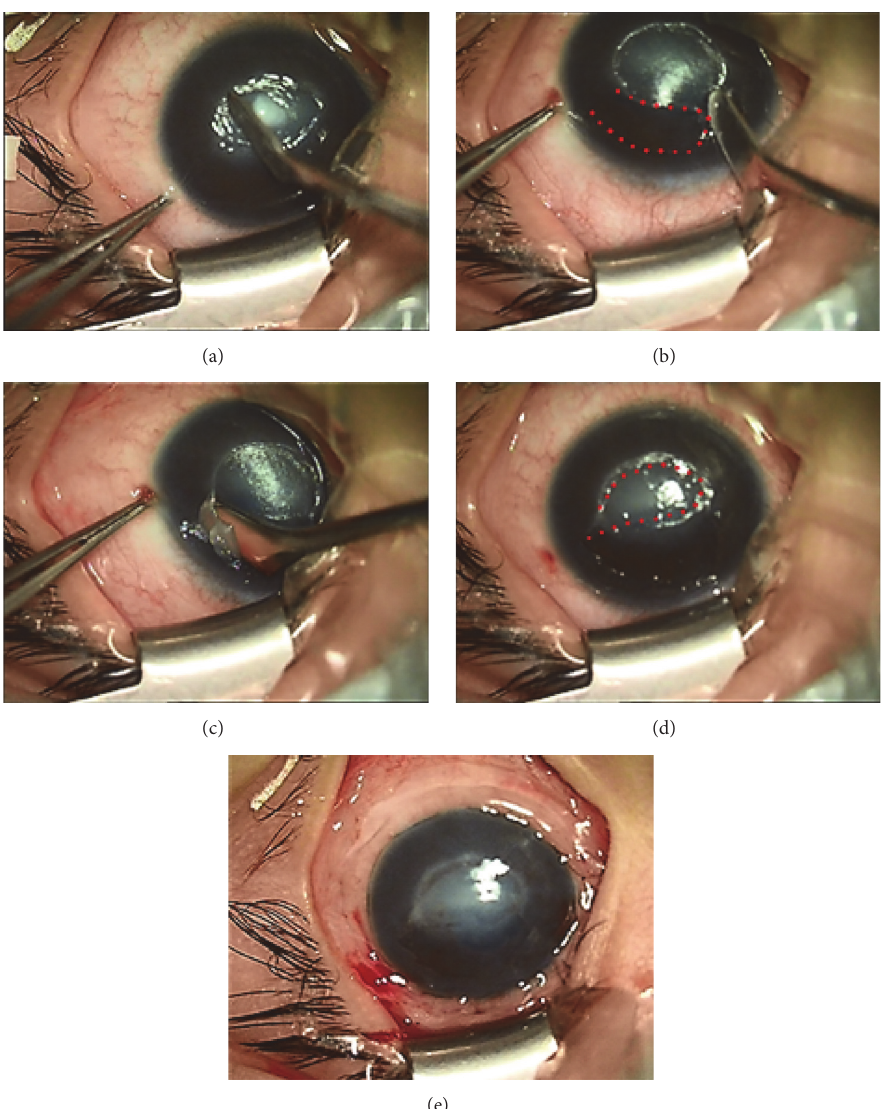
Figure 1: Photographs showing the procedures of epithelial flap transposition combined with amniotic membrane transplantation. (a) Cleaning the ulcer surface. (b) Constructing a flap boundary (the dotted line demonstrates the region from where the epithelial flap was obtained). (c) Obtaining an epithelial flap. (d) Transposing the epithelial flap (the dotted line demonstrates the translocated epithelial flap). (e) Suturing an amniotic membrane